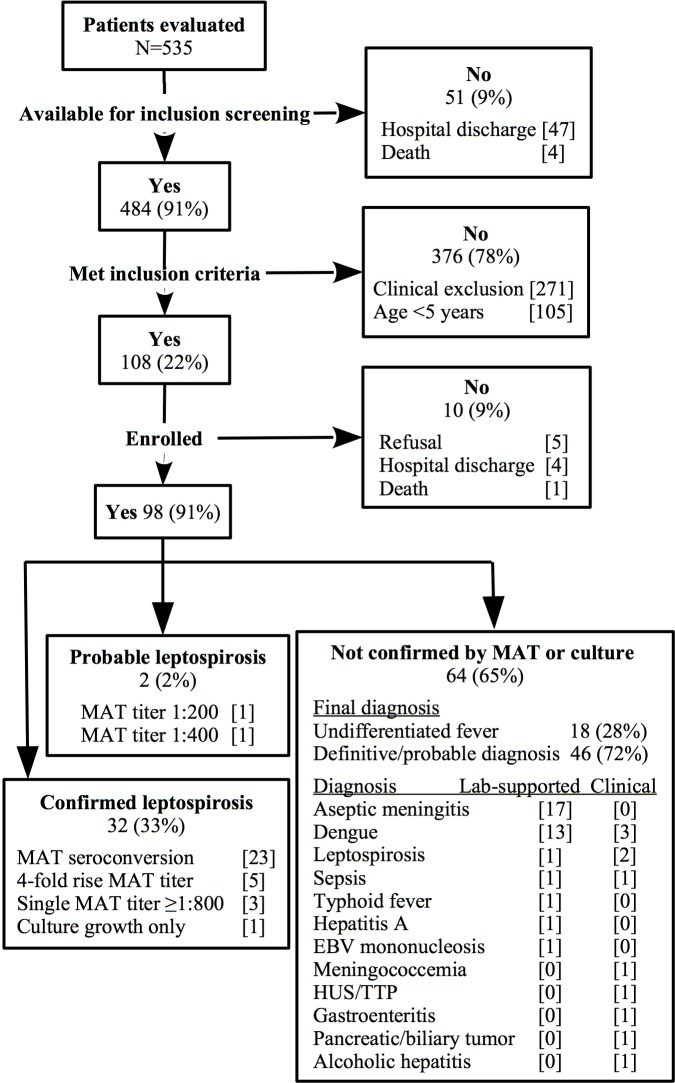
Recruitment of patients hospitalized for acute febrile illness compatible with leptospirosis–Salvador, Brazil 2012.* Undifferentiated fever includes any other febrile illness consistent with acute clinical leptospirosis not elsewhere categorized. EBV = Epstein-Barr virus. HUS/TTP = hemolytic uremic syndrome/thrombotic thrombocytopenic purpura.